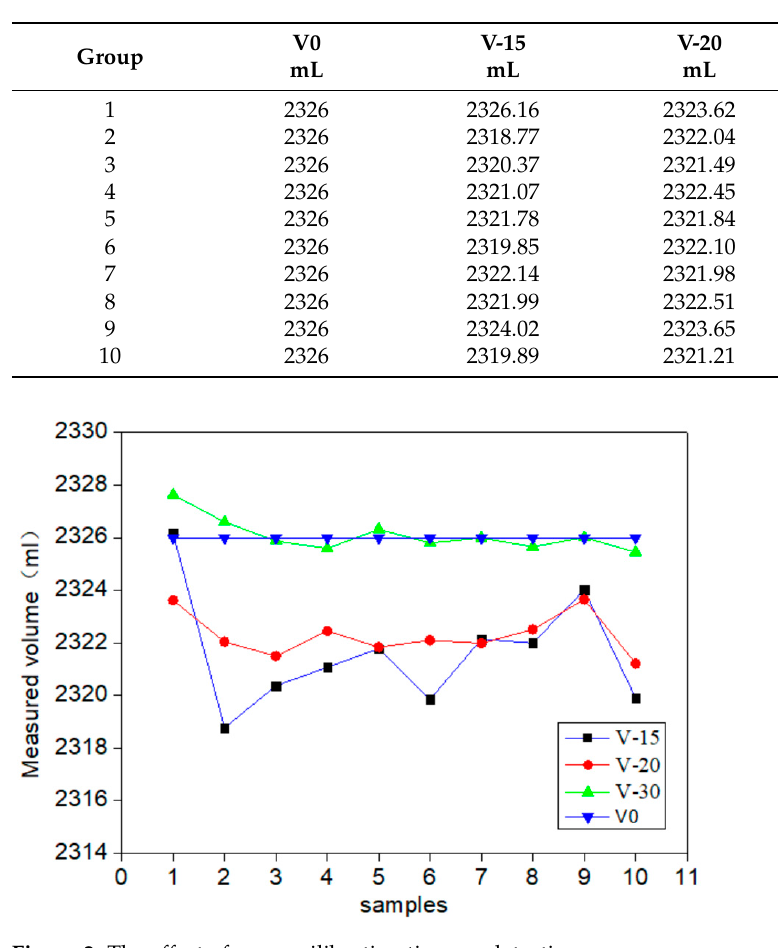
Figure 2. The effect of gas equilibration time on